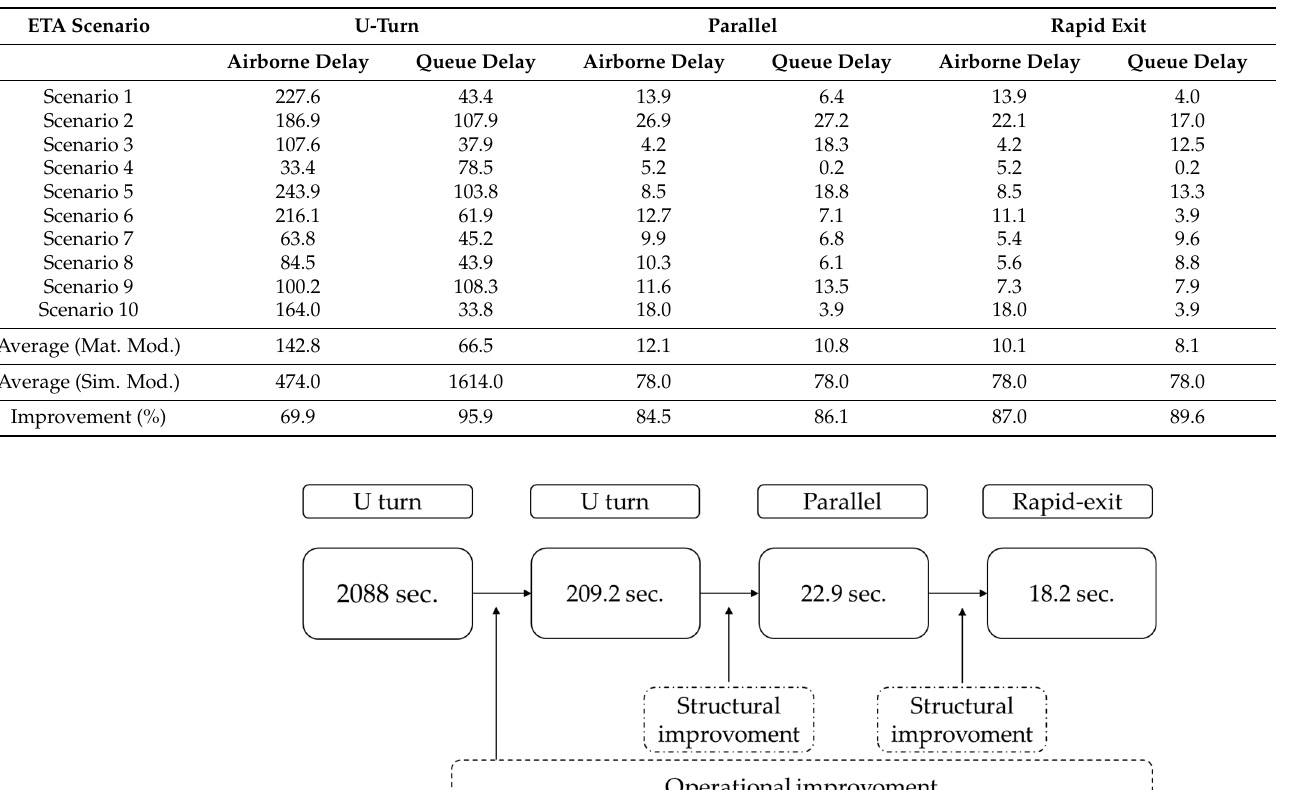
Table 16. Mathematical model results (sec.).